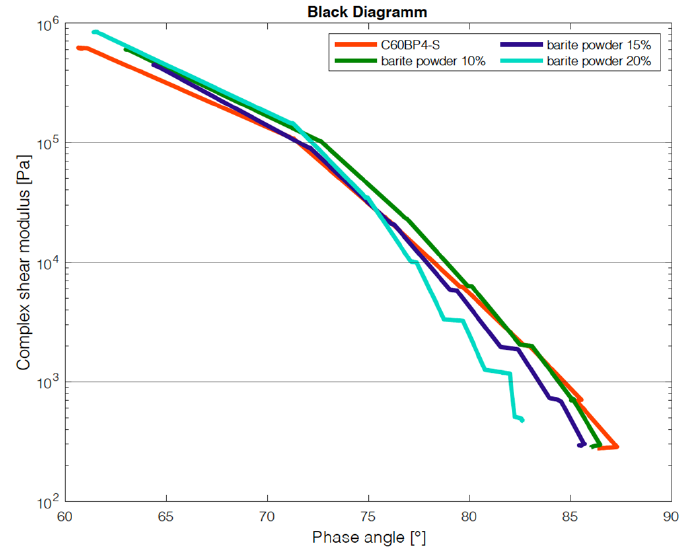
Figure 14. DSR results of addition of barite powder.